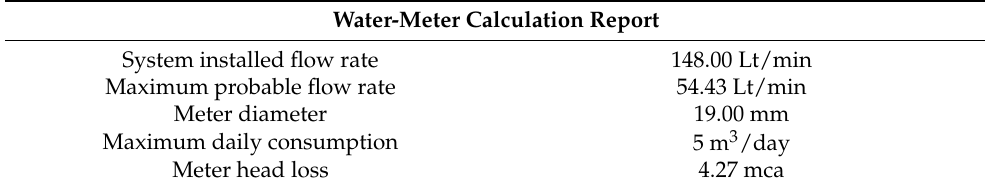
Table 8. Water-meter calculation report for a single-family house.